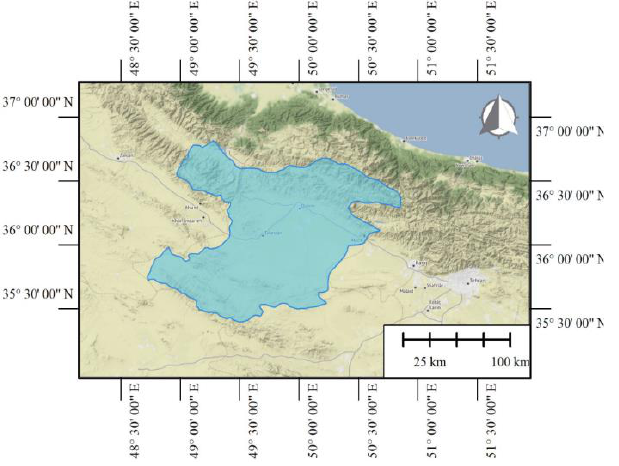
Figure 1 . location of Qazvin plain in Iran.